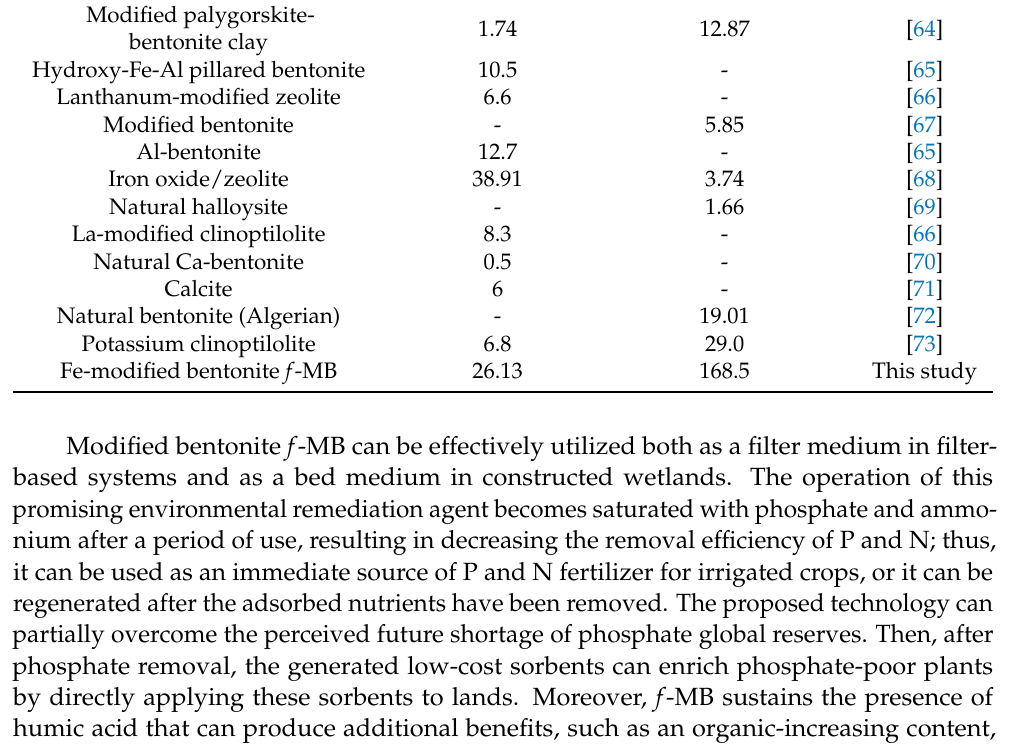
Table 3. Comparison of phosphate adsorption capacity (qm) of tested material reported in the literature.